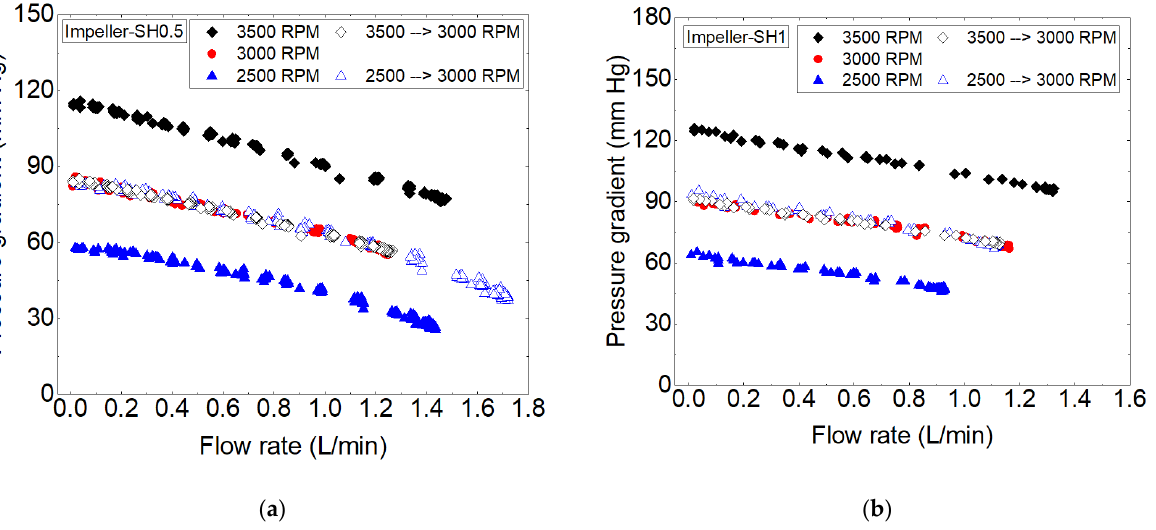
Figure 7. Experimental hydraulic performances of the pumps with ( a ) impeller SH0.5 and ( b ) impeller SH1 at different rotational speeds.